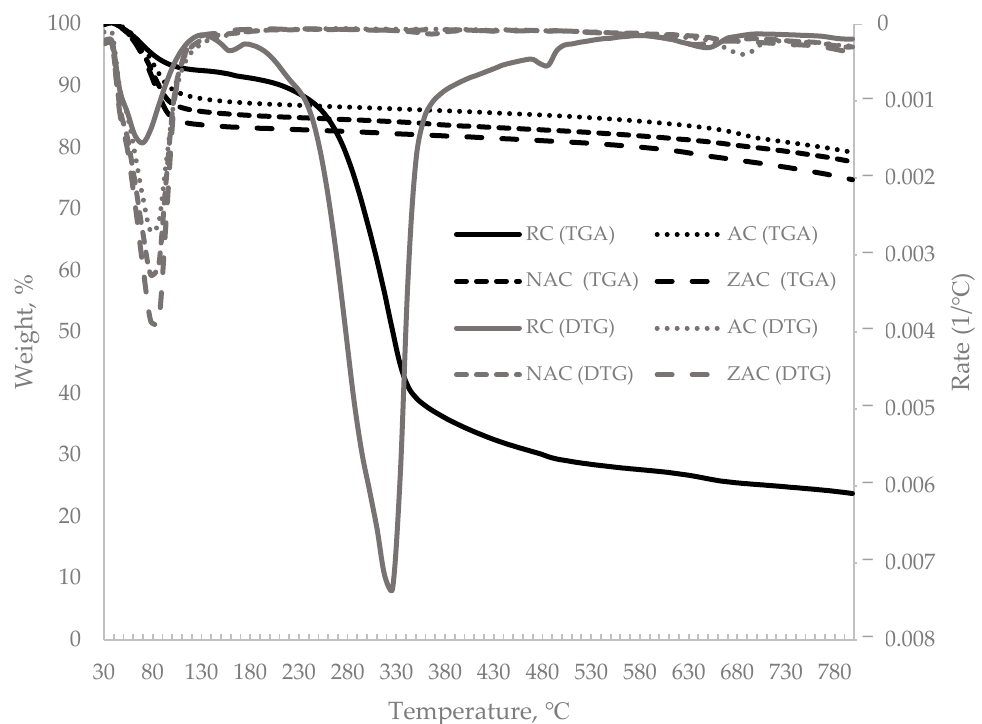
Figure 5. The TG and DTG curves for all types of cassava stem adsorbents.